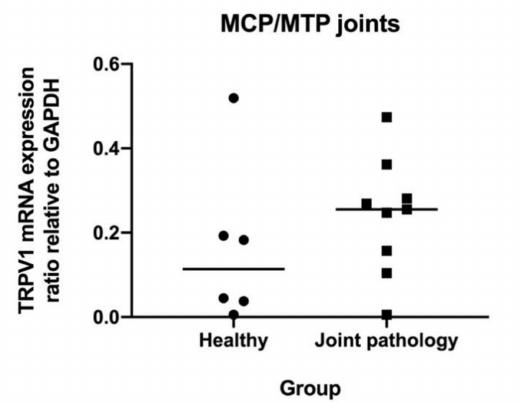
Figure 5. TRPV1 mRNA expression ratio relative to glyceraldehyde 3-phosphate dehydrogenase (GAPDH) in synovial membrane tissue from metacarpo-phalangeal / metatarso-phalangeal (MCP / MTP) joints. Symbols indicate individual joints (circles = healthy; squares = joint pathology). Mean is indicated by horizontal